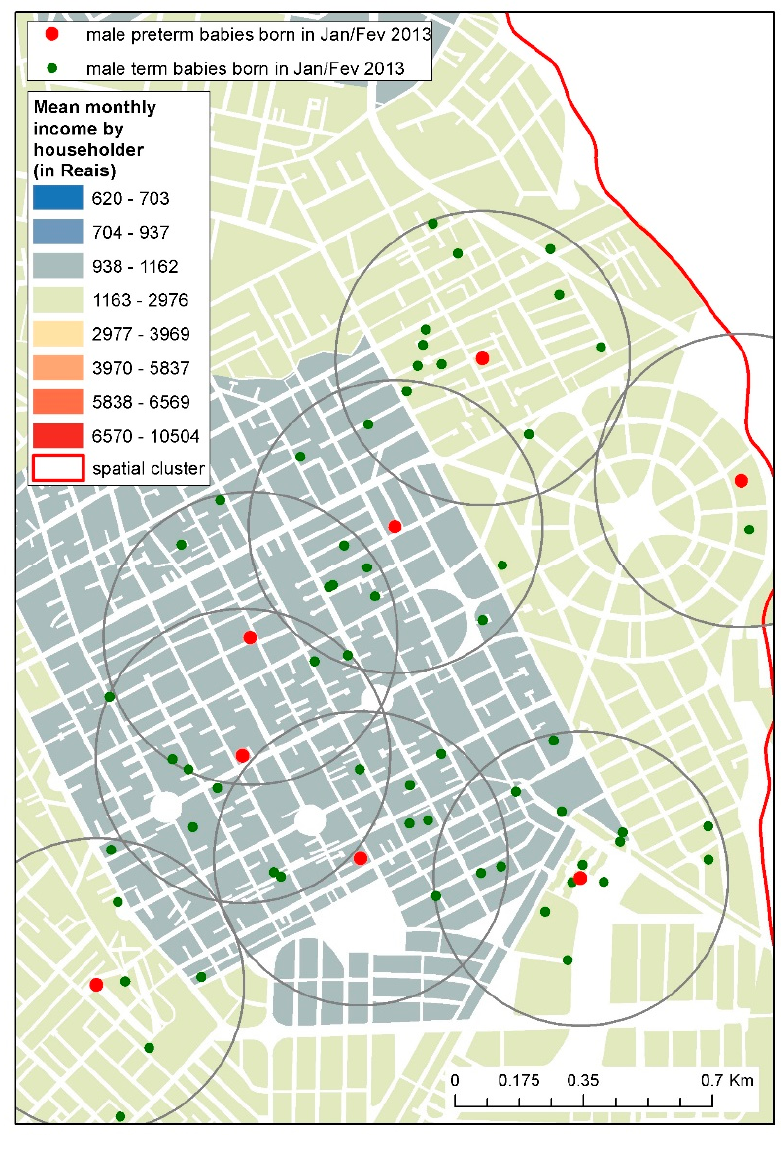
Figure 2. Example of spatial distribution of case-controls. The map depicts male term and preterm babies born in January and February 2013 and a 400 m-buffer from preterm babies overlaid on a map of mean monthly income by householder in a small portion of the municipality.